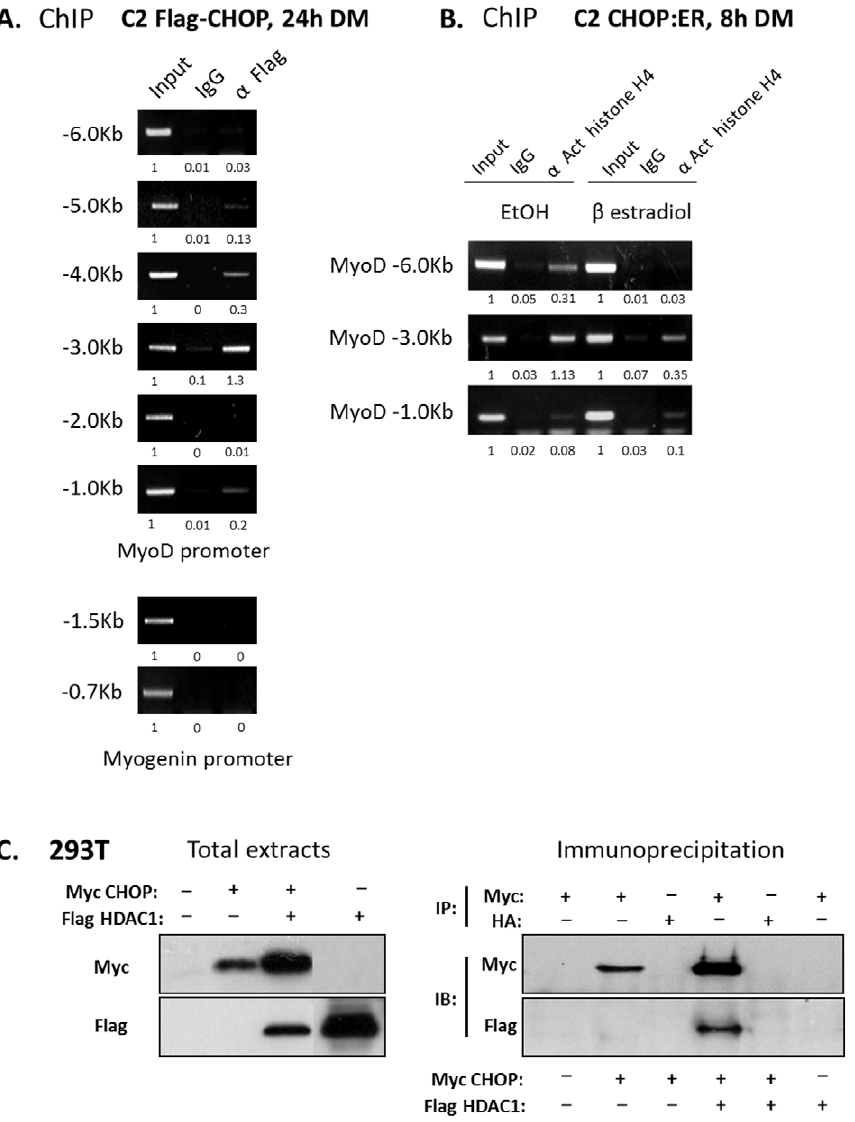
Figure 7. CHOP associates with MyoD regulatory sequences and affects histone acetylation. (A) A Chromatin IP experiment was performed on C2C12 cells expressing Flag-CHOP that were grown in DM for 24 hours. Immunoprecipitation of fragmented DNA was performed with anti-Flag antibodies. PCR amplification of fragments scattered throughout 6 Kb upstream region of the MyoD transcription unit and along 2 Kb upstream of the myogenin transcription unit was performed. PCR fragments were separated over agarose gels. Gels were scanned and values of band intensities are presented below. For each set of PCR primers, the value of the input was set to 1. (B) C2C12 cells expressing CHOP:ER chimera were grown in DM for 8 hours in the presence of ethanol or b estradiol (0.1 m M). Chromatin IP assay was performed on fragmented DNA with anti- acetylated histone H4 antibody. PCR amplification of fragments scattered along 6 Kb upstream of the MyoD transcription unit was performed. Gels were scanned and values of band intensities are presented below. For each set of PCR primers, the value of the input was set to 1 (C) 293T cells were transfected with expression plasmids as indicated. Cells were lysed under mild conditions and extracted proteins were analyzed (left) or immunoprecipitated with anti-Myc or anti-HA epitope antibodies as indicated (right). Proteins were analyzed by Western blotting as